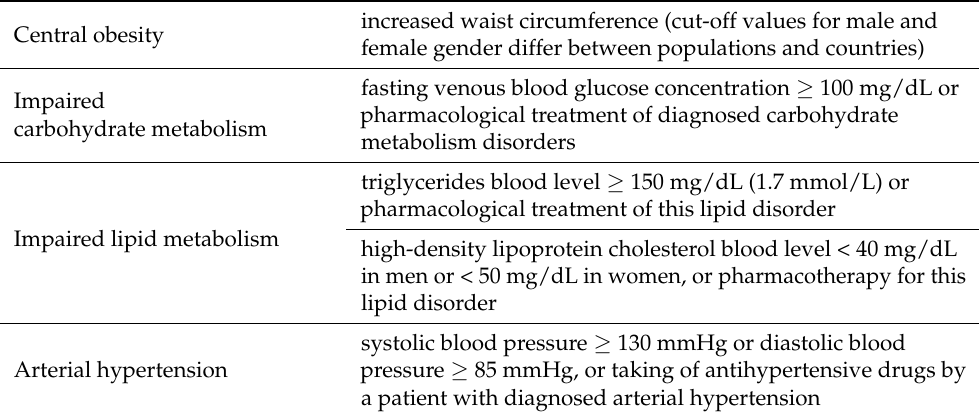
Table 1. Components of metabolic syndrome (MS) and its diagnostic criteria. MS can be diagnosed when at least three conditions are met